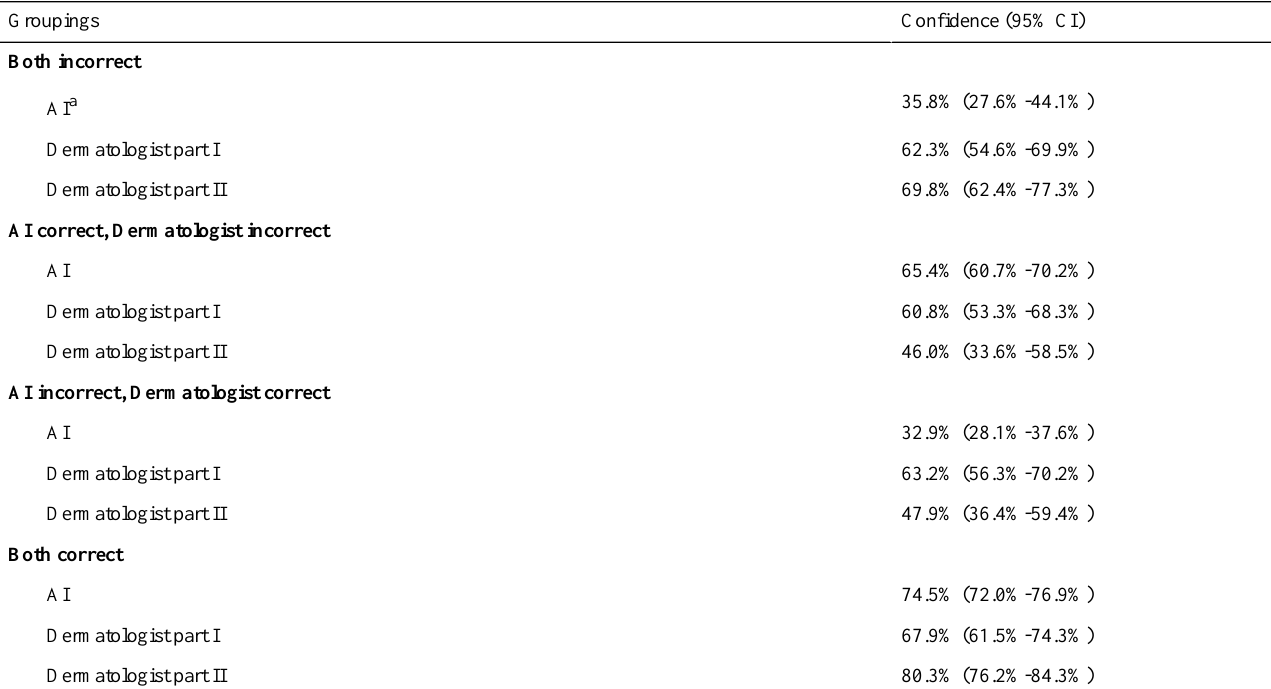
Table 3. Confidence distribution of the classifier and dermatologists for part I and part